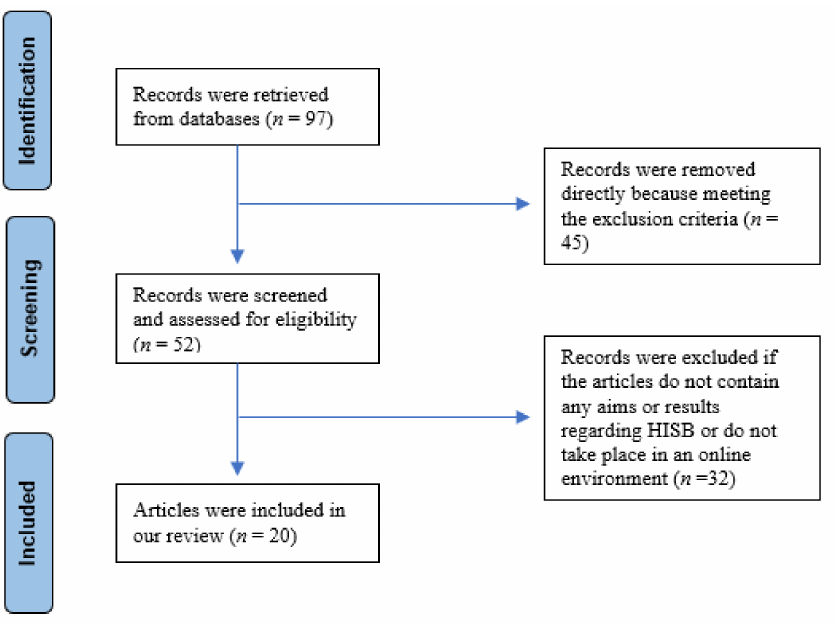
Figure 1. The flowchart of records retrieved, removed, and